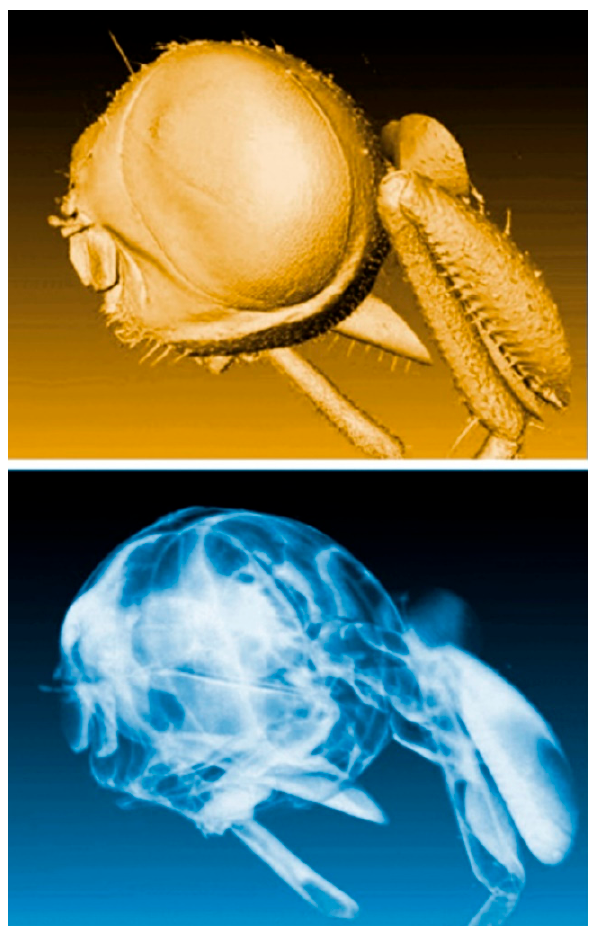
Figure 5. Two other coherence-based X-ray images of part of a housefly [14].